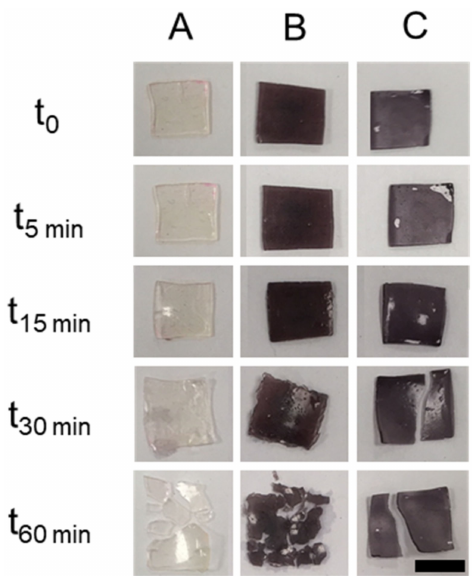
Figure 7. Representative images of films immersed in phosphate bu ff ered saline (PBS) at di ff erent times. Control ( A ), CTAB-GnRs film ( B ), and PEG-GnRs film ( C ) (scale bar represents 1 cm).